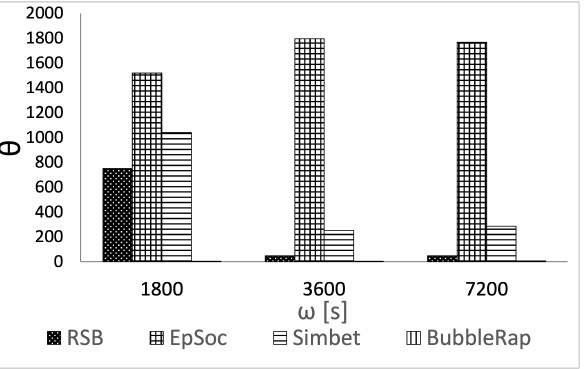
Figure 9. Overhead ( θ ) as a function of the message generation interval ( ω ).